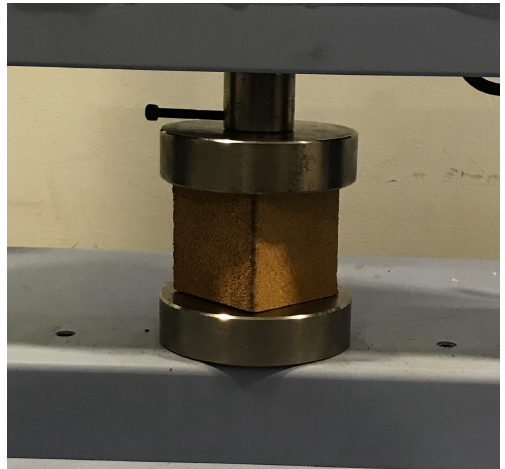
Figure 3. Agglomerated cork sample positioned for uniaxial compression testing at quasi-static strain rates.